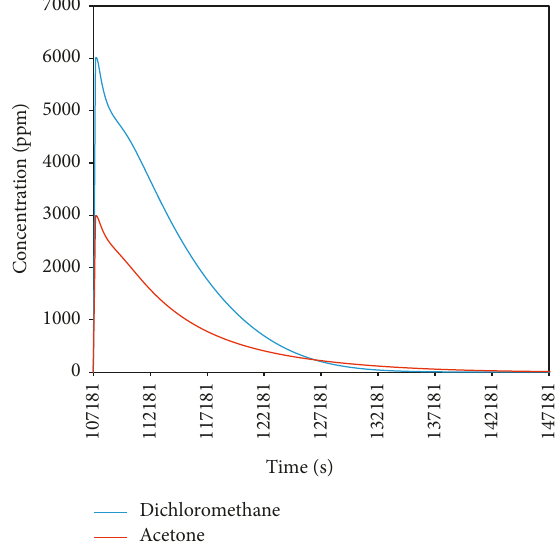
Figure 12: Histories of dichloromethane and acetone concentra- tion at the bed exit during evacuation and purge steps at cyclic steady state.